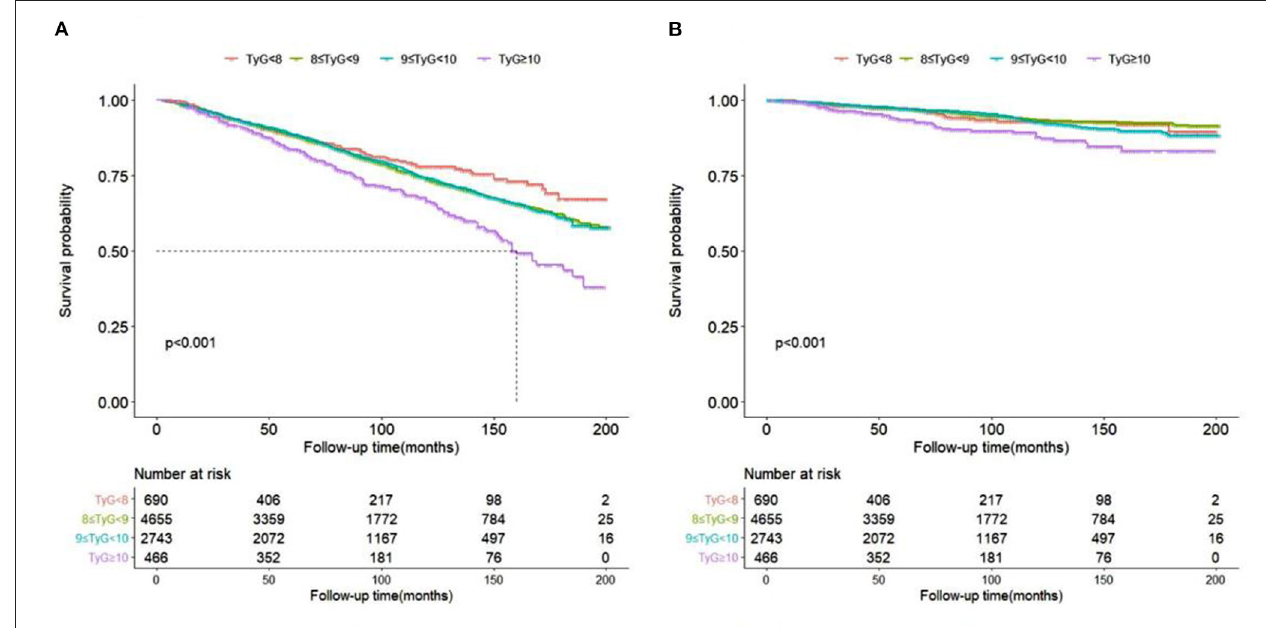
FIGURE 3 | Kaplan-Meier survival curve for all-cause (A) and cardiovascular (B) mortality by TyG